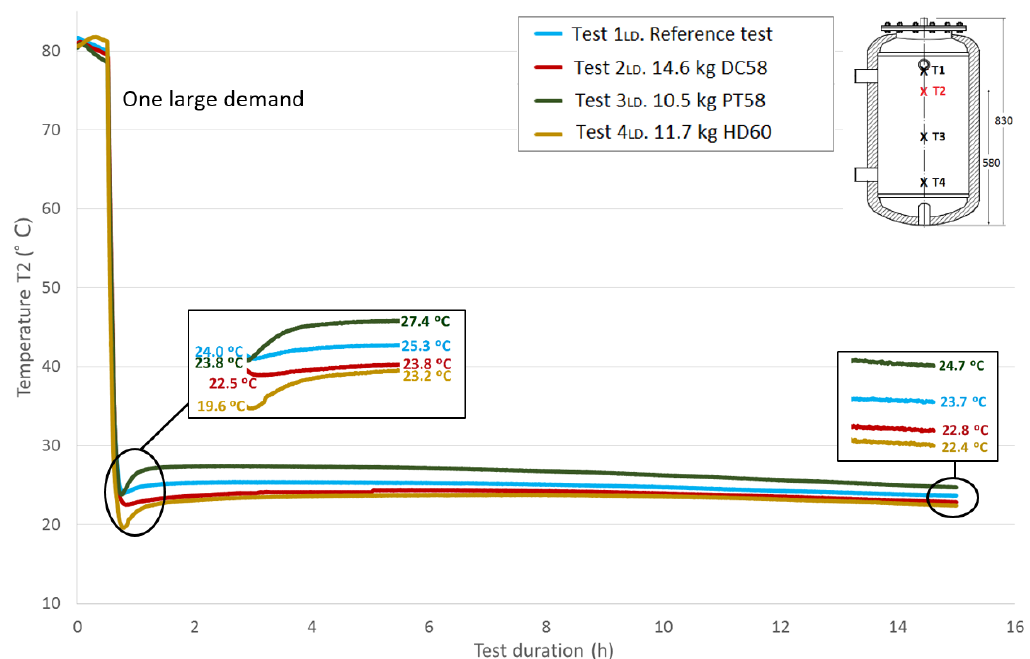
Figure 9. Medium top height water temperature ( T 2) inside the tank during the one large demand experiment. (dimensions are in mm).